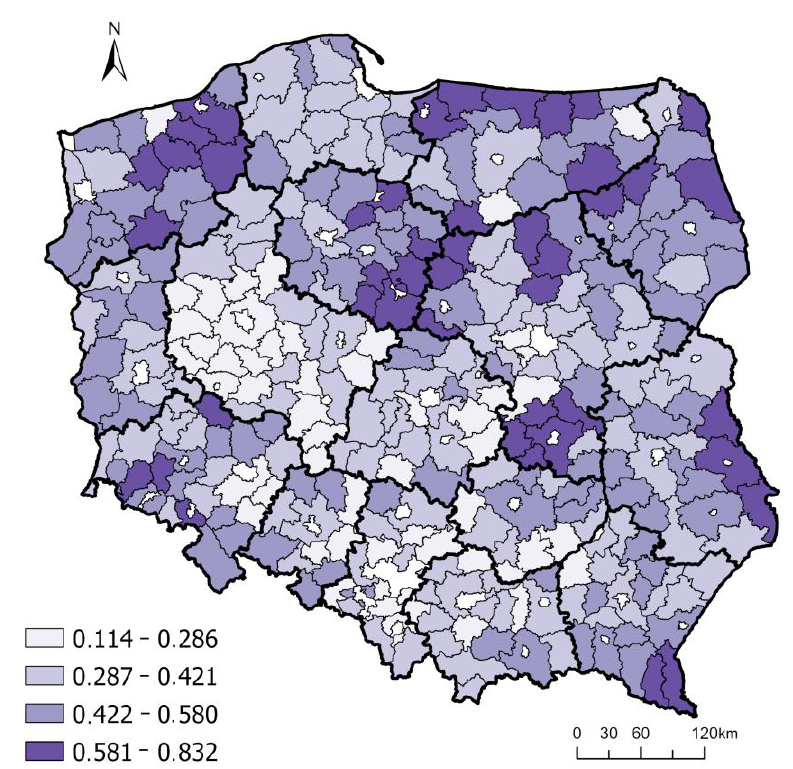
Figure 6. Social dimension of the quality of life—W s . Source: own elaboration.